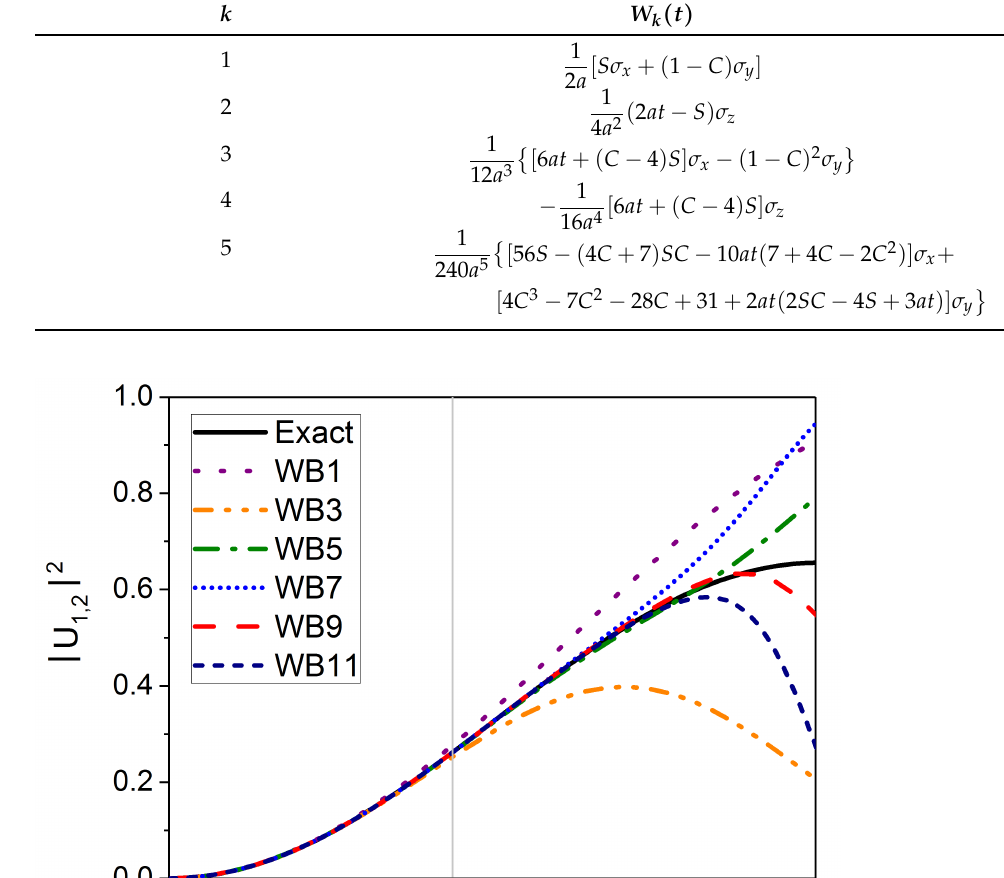
Table 1. First five orders in Bellman problem for generic t . The operators C k in Equation (95) are obtained by taking t = 1, i.e., C k = i W k ( 1 ) . We have defined S ≡ sin ( 2 at ) and C ≡ cos ( 2 at ) .